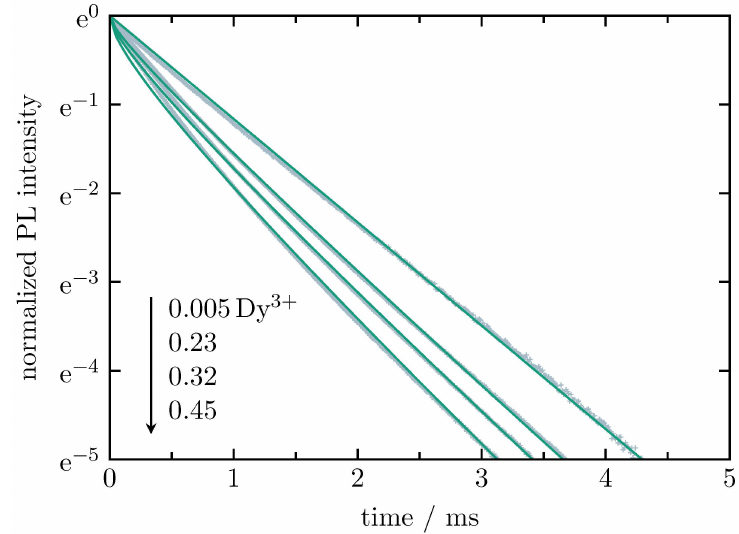
Figure 10. Normalized radiative decay curves of Dy 3 + in Dy 3 + single-doped BaB glass with varying Dy 3 + contents (all values are in at.%), recorded for the Dy 3 + -related 4 F 9/2 to 6 H 13/2 transition at 575 nm under 455-nm excitation. The solid curves (green) represent the best fit on the basis of the Inokuti–Hirayama model with the multipolar interaction parameter, S , set to 6 (dipole–dipole